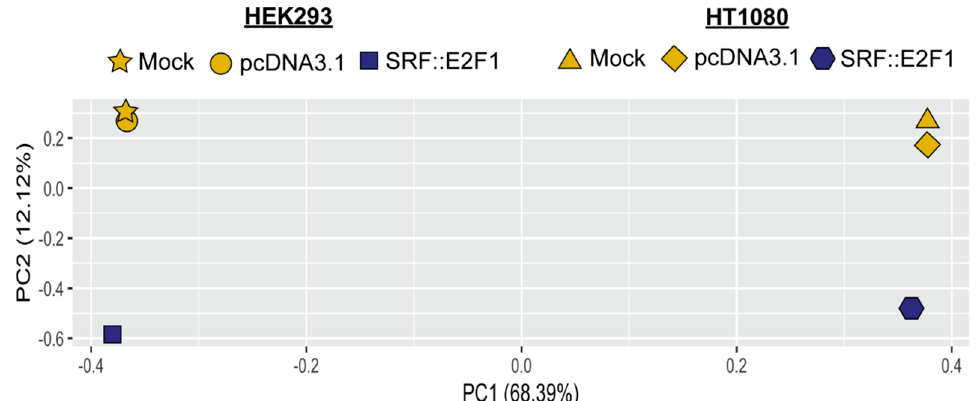
Figure 2. Principal component analysis (PCA) performed on HEK293 and HT1080 cells transfected with SRF::E2F1 fusion transcript analyzed by RNA-sequencing. The unsupervised PCA analysis shows the segregation along the first component between the two different cell lines (HEK293 and HT1080), and, for both cell lines, along the second component between SRF::E2F1 -overexpressing cells (in blue) and controls (in yellow).